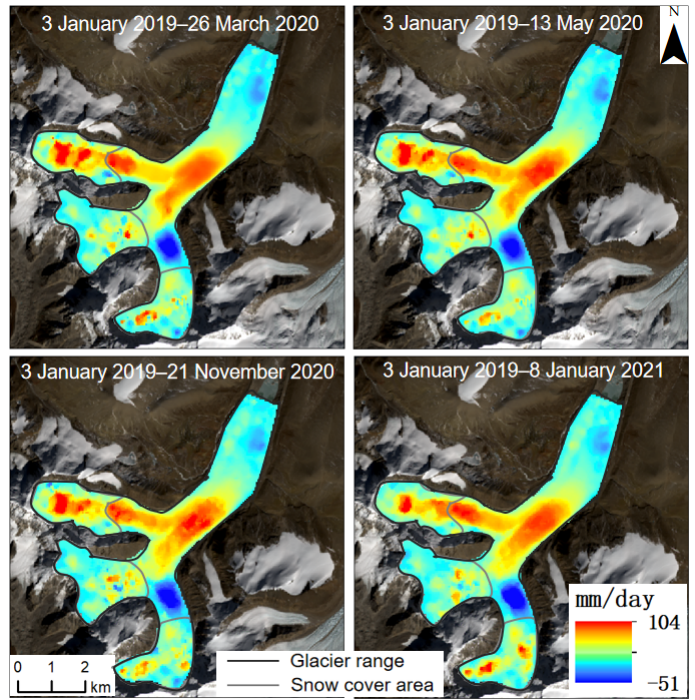
Remote Sens. 2022 , 14 , x FOR PEER REVIEW Figure 12. West–east time-series glacier velocity in the study area. Figure 12. West–east time-series glacier velocity in the study area.